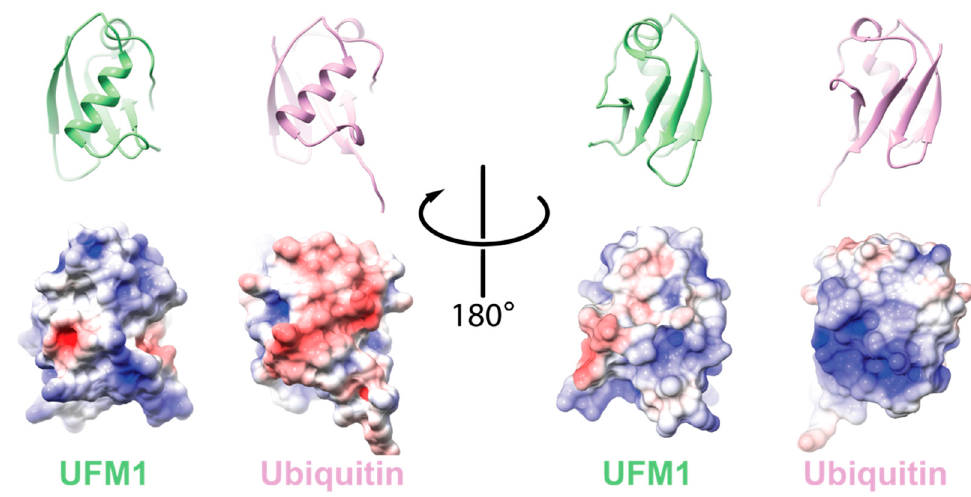
Figure 1. Comparison between electrostatic potential surfaces of ubiquitin-fold modifier 1 (UFM1) (PDB id 5IA7) and ubiquitin (Ub) (PDB id 1UBQ). Upper panel: cartoon representation of the orientation of the indicated protein; lower panel: the corresponding electrostatic surface. The electrostatic potential surface was calculated using UCSF Chimera [13].